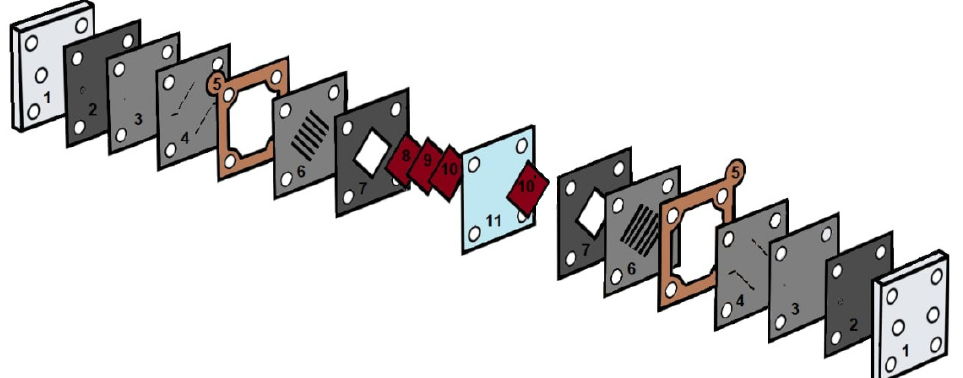
Figure 1. The design of a hydrogen − bromate fl ow cell: 1—titanium end plates with compression fittings, 2—sealing gaskets, 3, 4, 6—graphite foil plates with the flow fields, 5—a current collector plate made of copper foil, 7—electrode pads, 8, 9, 10,—carbon paper cathode; 10 ′ —Pt catalyzed gas diffusion anode, 11—cation exchange membrane.